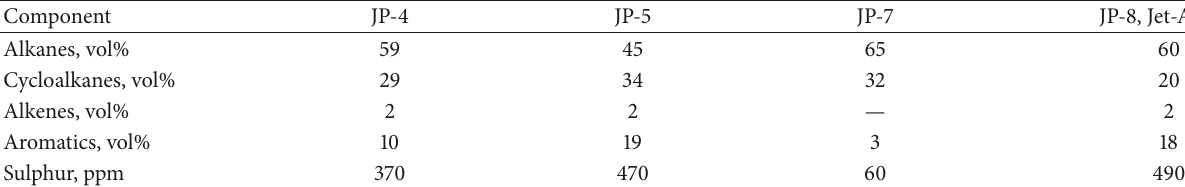
Table 1: Composition (volume fraction of components) of conventional aviation fuels.